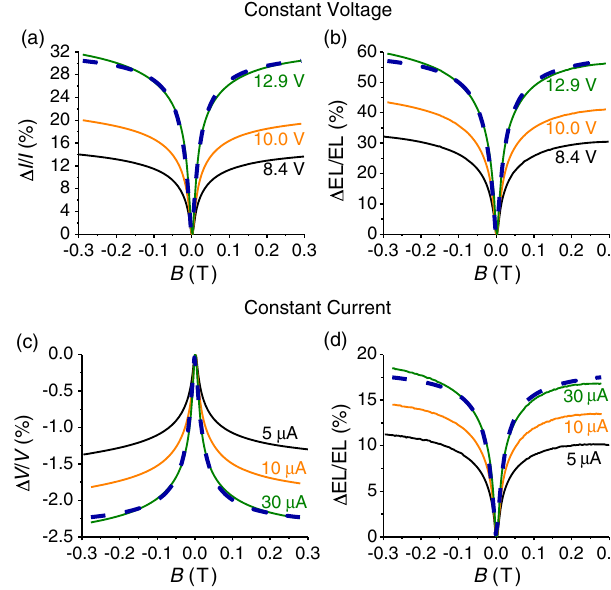
FIG. 4. (a) Magnetoconductance (MC) and (b) magnetoelectro- luminescence (MEL) before device conditioning for three representative constant voltages. (c) Magnetovoltage and (d) magnetoelectroluminescence before device conditioning for three representative constant currents. The same color is used throughout the figure to designate measurements with a compa- rable current density. Thick dashed lines are non-Lorentzian (as defined in text) fits to the largest displayed curve in each panel.